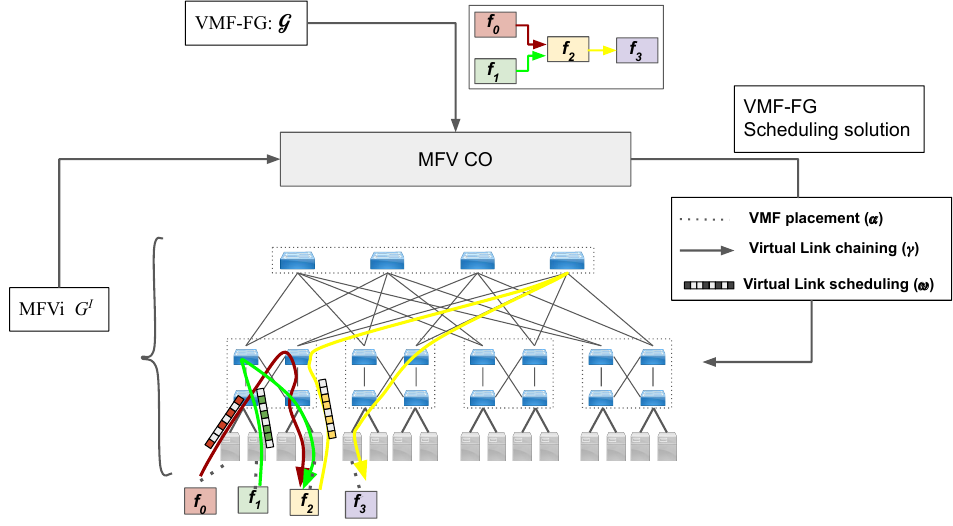
Figure 3. An overview of the VMF-FG scheduling